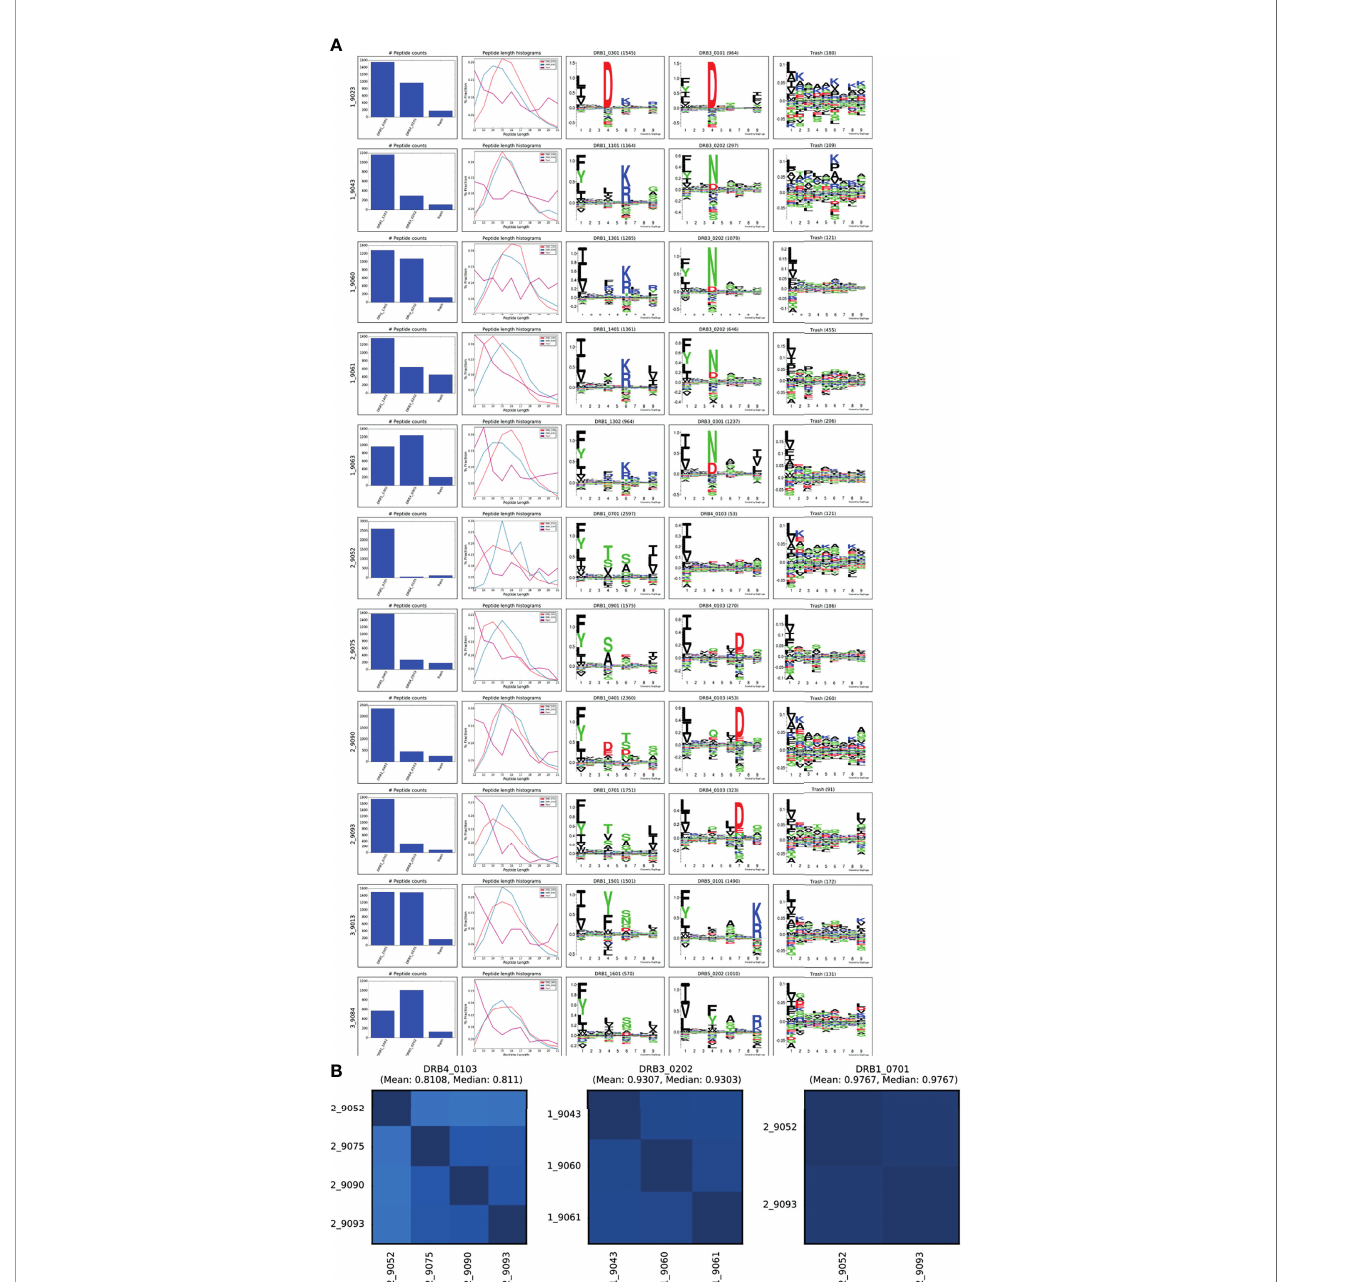
FIGURE 6 | MHCMotifDecon analysis for the MS peptidomics data obtained from the 11 cell lines. Peptide datasets were fi ltered for HLA class I binders as described in the text and submitted to MHCMotifDecon for motif deconvolution using default class II options. (A) Peptide counts, length distribution per alleles or trash cluster, and logos from HLA-DR alleles after deconvolution by the method. Each row corresponds to one dataset (cell line). The label N_ in front of each cell line (i.e., 1_9023) corresponds to the different haplotype groups (see Supplementary Table 1 ). The fi rst column shows the number of peptides assigned to each HLA molecule and the Trash bin (containing peptides with a predicted rank > 20%). The second column gives the peptide length distribution for each HLA, and Trash bin, and the remaining columns the binding motifs for each HLA molecule and Trash bin. Motifs are constructed from the predicted binding cores using Seq2Logo (23) with default settings. (B) Consistency matrices generated by the method for the three DR molecules shared between 2 or more cell lines using the method described in (15) de fi ning the similarity between two HLA binding motifs in terms of the Pearson ’ s correlation coef fi cient (PCC) between the two vectors of 9*20 elements (9 positions and 20 amino acid propensity scores at each position). Note. that the consistency plot for DRB4*01:03 includes the null allele DRB4*01:03N expressed in the 9052 cell line. Removing this allele from the plot results in increasing the Mean PCC value to